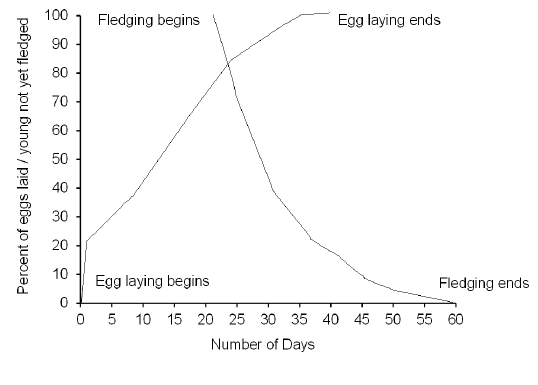
Fig. 3 . Generalized annual patterns of timing of egg-laying and fledging in Bobolinks ( Dolichonyx oryzivorus ), following Winter et al. (2004) and Bollinger et al. (1990), respectively. As indicated, overlap occurs when young hatching from the earliest nests will fledge before all of the eggs have been laid in the